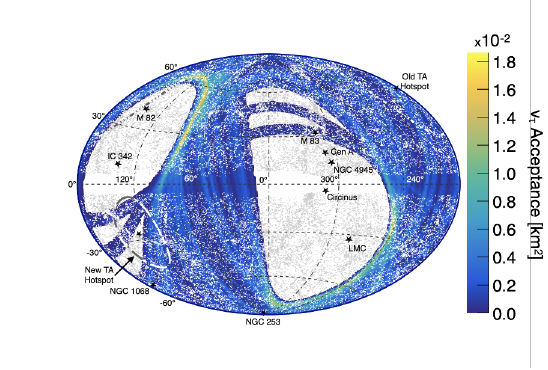
Figure 11: Sky plot of the tau neutrino acceptance at 10 8 . 5 GeV averaged over 100 days, assuming launch on April 1, 2023.